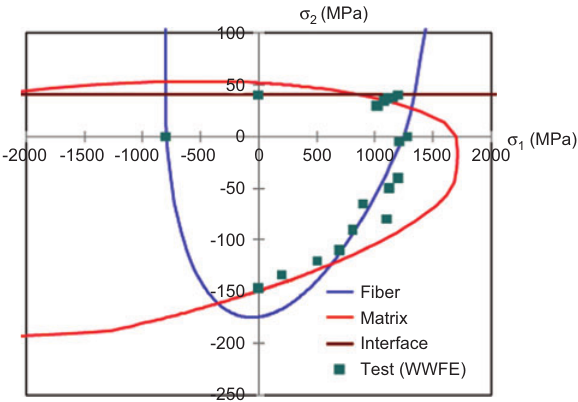
Figure 9 MMF constituents (fi ber, matrix and interface) failure envelope for unidirectional E-glass/MY750 ply in σ compared to WWFE test data (adapted from Ha et al. [2] ).